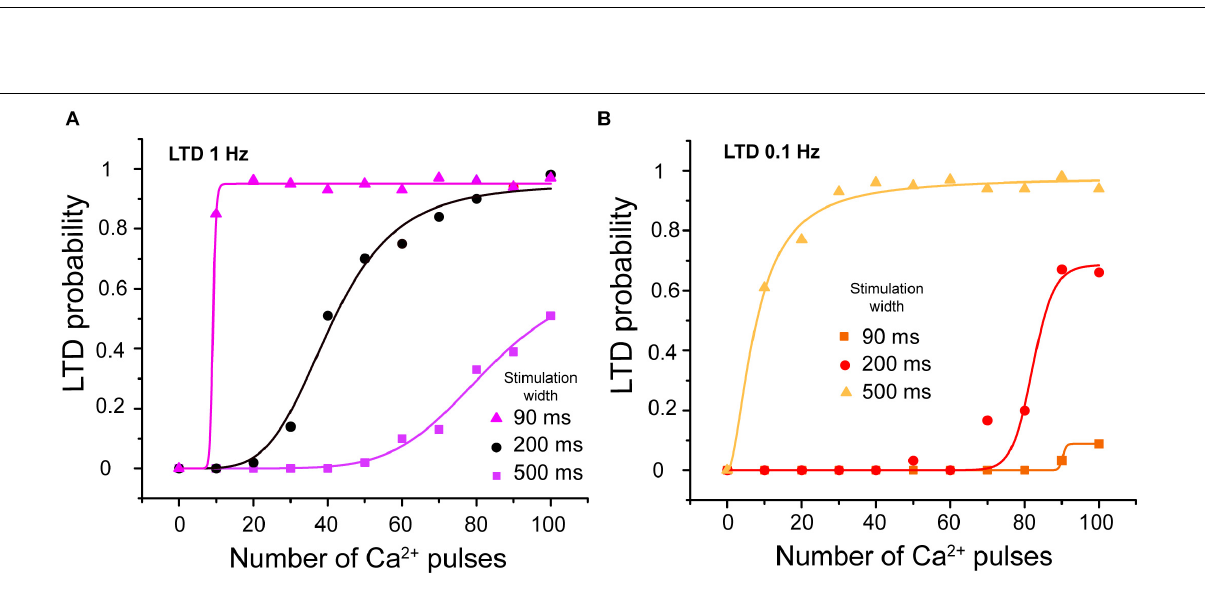
Frontiers in Molecular Neuroscience |